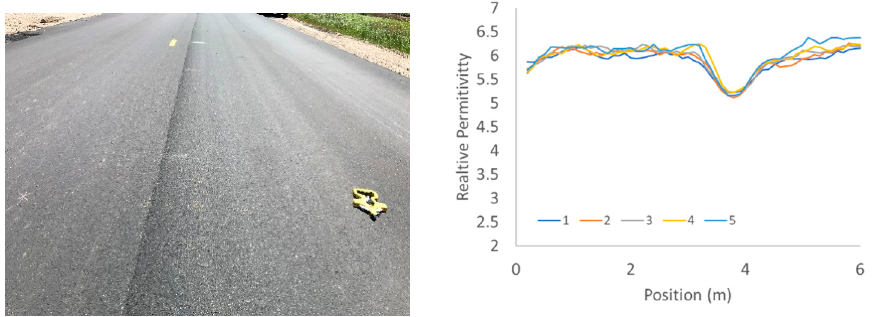
Figure 5. View of the new pavement ( left ) where the centerline joint response is clearly visible at the ~4 m position during a cross-lane test ( right ). Numbers 1 to 5 in the right plot indicate the number of repeats of the cross-lane test.